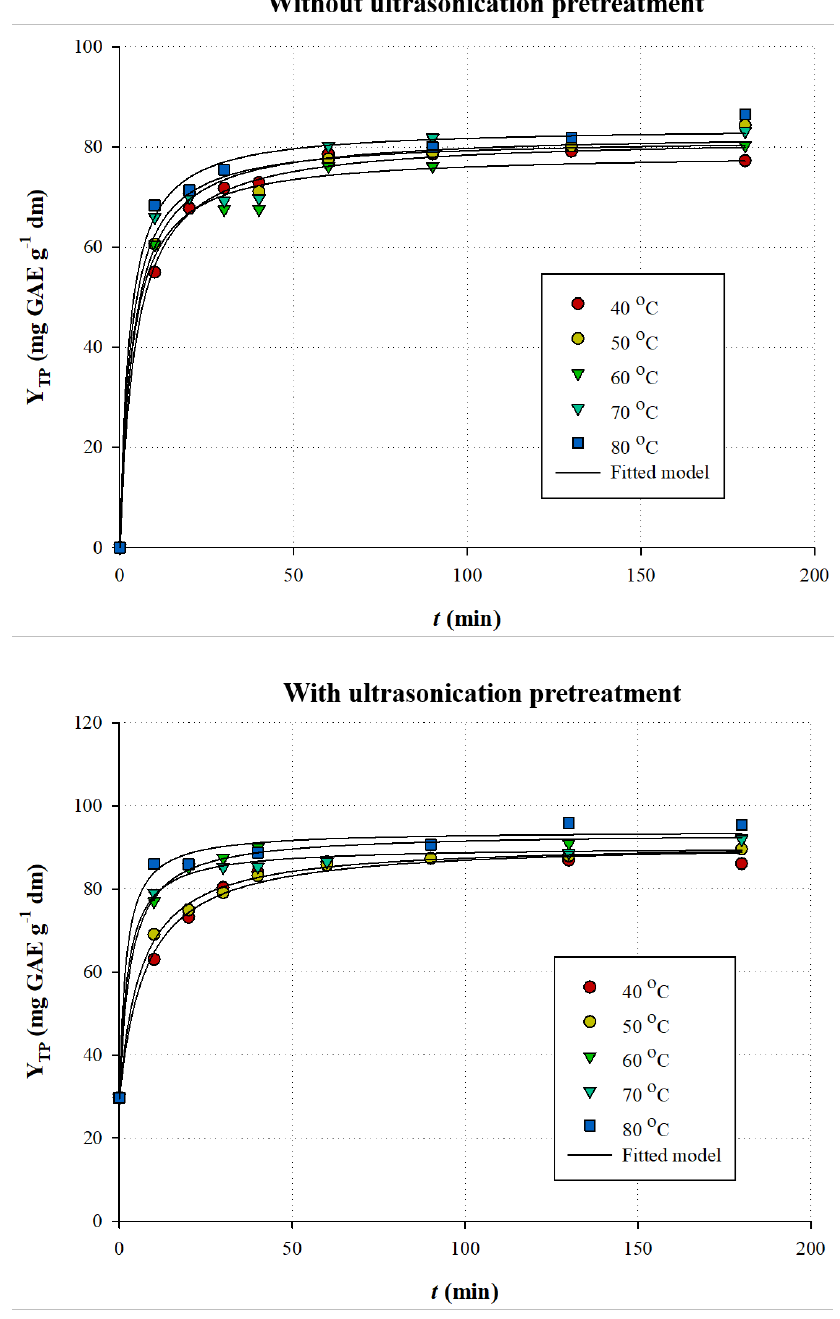
Figure 5. Kinetics of polyphenol extraction from M. oleifera leaves, with and without prior ultrasonication pretreatment. Extraction conditions for the non-pretreated sample: C DES = 85% ( w/w ); R L/S = 20 mL g −1 ; S S = 800 rpm. Extraction conditions for the ultrasonication-pretreated sample: C DES = 75% ( w/w ); R L/S = 100 mL g −1 ; S S = 200 rpm.